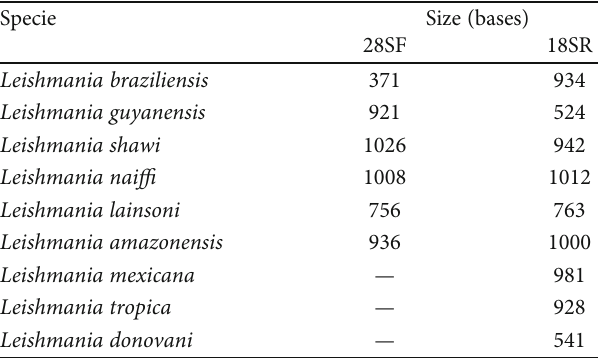
Table 4: Number of bases sequenced per Leishmania species after capillary